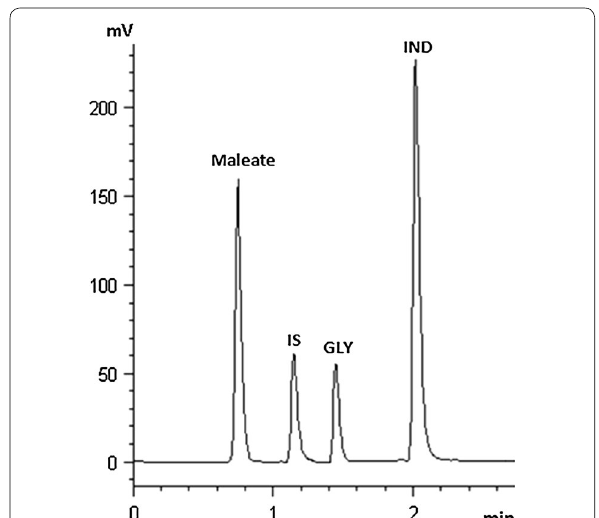
Fig. 2 Representative HPLC chromatogram of indacaterol maleate (IND; 22 µg/mL), glycopyrronium bromide (GLY; 10 µg/mL) and ten- oxicam (IS; 15 µg/mL) in commercial capsules. Chromatographic con- ditions: monolithic C18 column (100 mm, 4.6 mm id); mobile phase: acetonitrile-30 mM sodium phosphate of pH 3.5 (30:70, v/v); flow rate 2.0 mL/min; column temperature of 35 °C; detection: 210